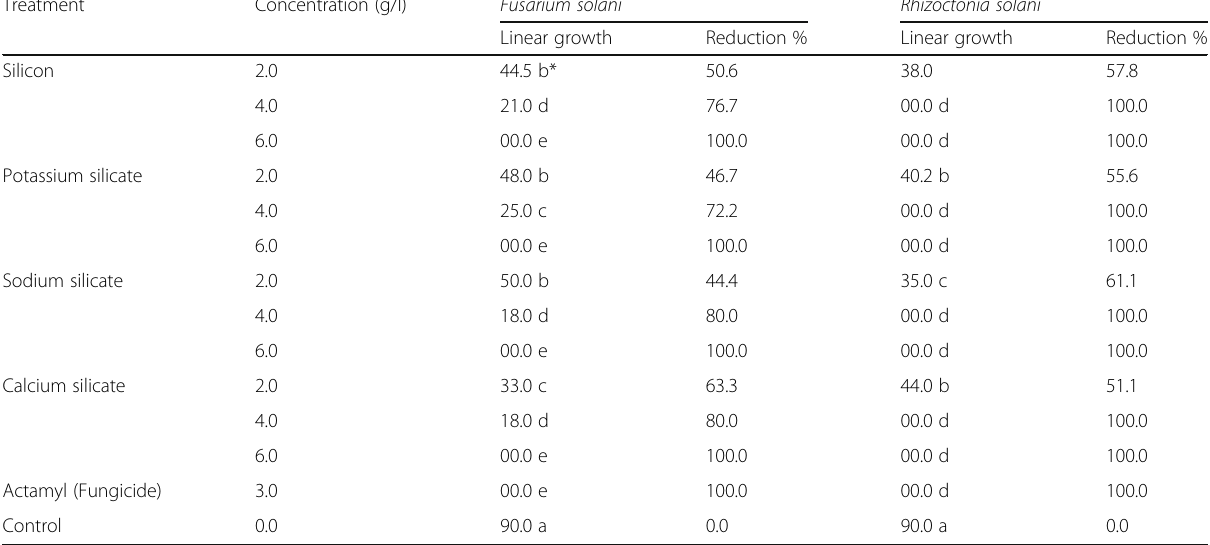
Table 1 Effect of silicon as well as potassium, sodium, and calcium silicates on linear growth of strawberry black root rot fungi under laboratory